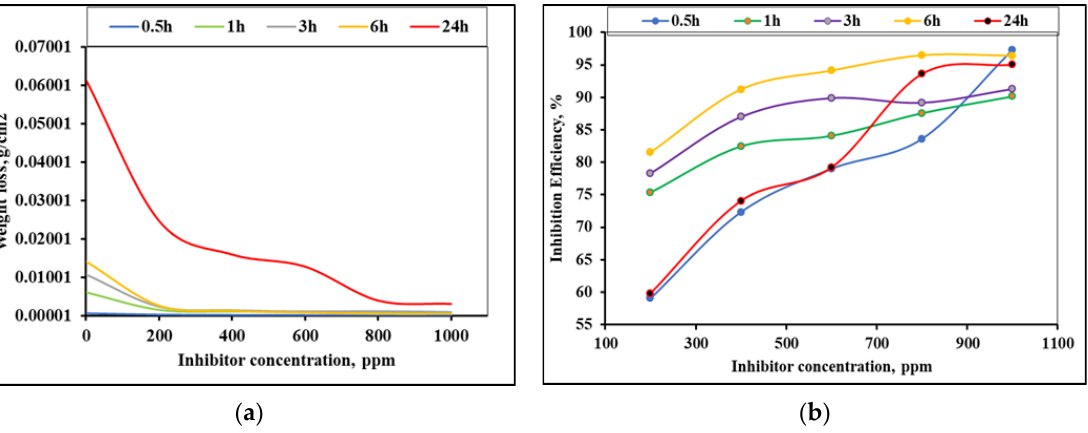
Figure 5. Effects of different concentrations of CNSA on ( a ) weight loss and ( b ) inhibition efficiency for the mild steel corrosion in 1 M H 2 SO 4 solution at various immersion times.